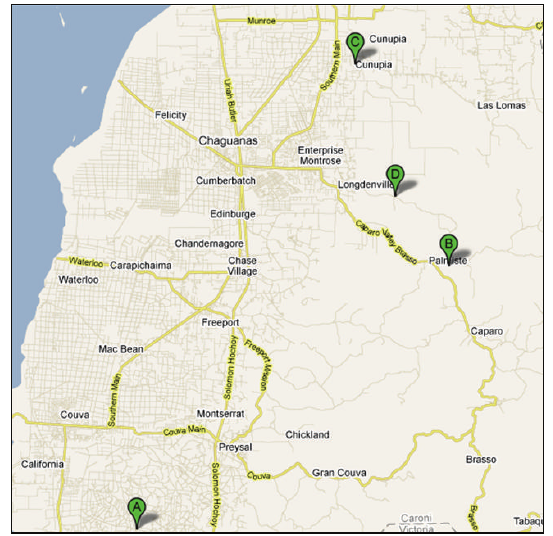
Figure 1: Blood sampling at farm locations of Central Trinidad. A: Couva farm; B: Palmiste farm; C: Cunupia farm; D: Sugarcane Feeds Centre,